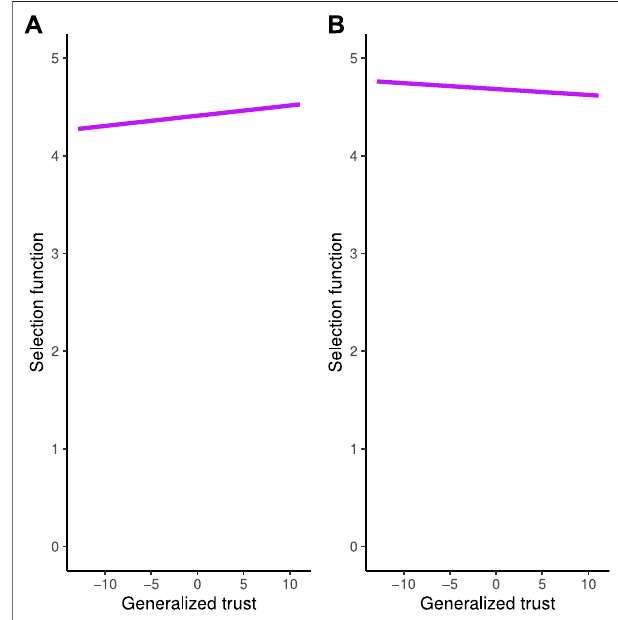
FIGURE 2 | Ego-alter selection plot for the effect of generalized trust on (A) thecreation and (B) theendowmentofadvicetiesforthemodelin Table2 [including Trust ego (creation or endowment), Trust alter, and Trust ego × alter].Thelinesindicatesocialselectionfunctionsforthreelevelsofego ’ s generalizedtrust[high(score (cid:1) 26),medium(score (cid:1) 19),andlow(score (cid:1) 11)] as a function of alter ’ s generalized trust (on the x -axis).